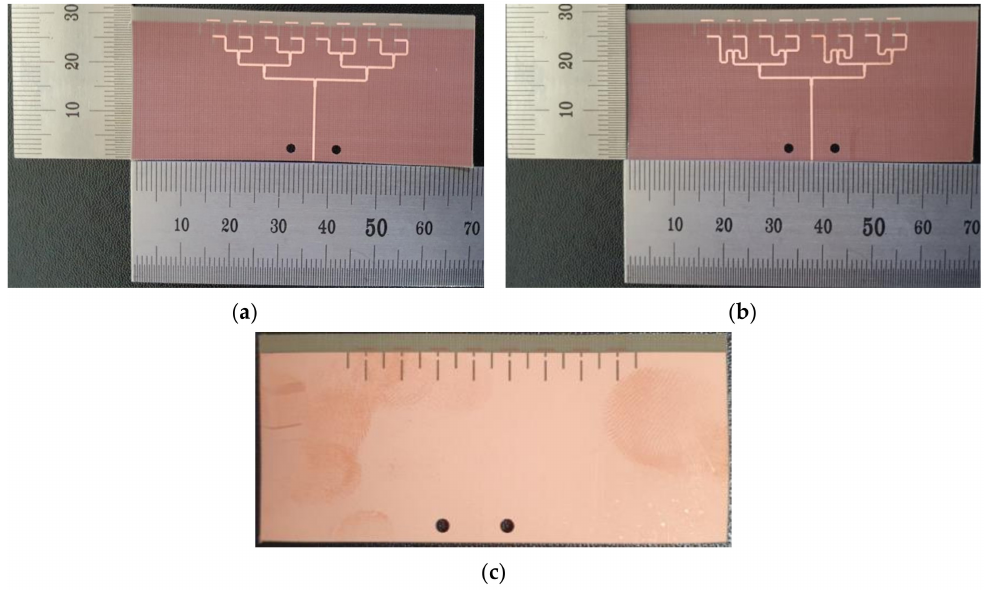
Figure 17. Photographs of fabricated antennas: ( a ) top side of the 1 × 8 array antenna with a 0 ◦ beam steering angle, ( b ) top side of the 1 × 8 array antenna with a fixed beam steering angle, and ( c ) bottom side of the 1 × 8 array